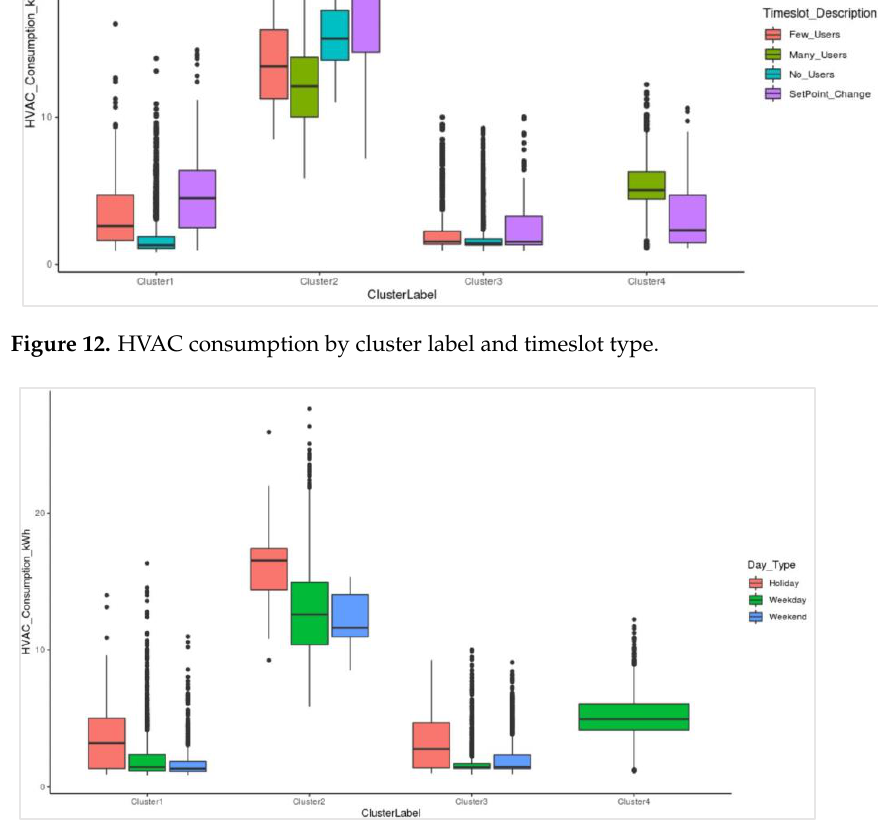
Figure 13. HVAC consumption by cluster label and day type.